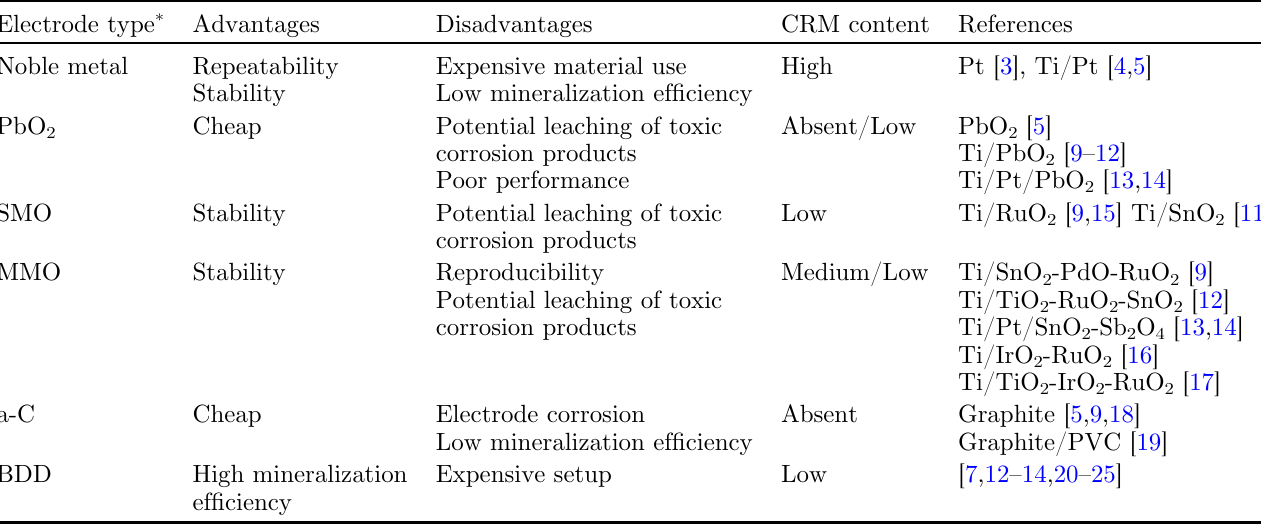
Table 1. Electrodes used for the electrochemical oxidation of land fi ll leachates reported in the literature. Electrode type